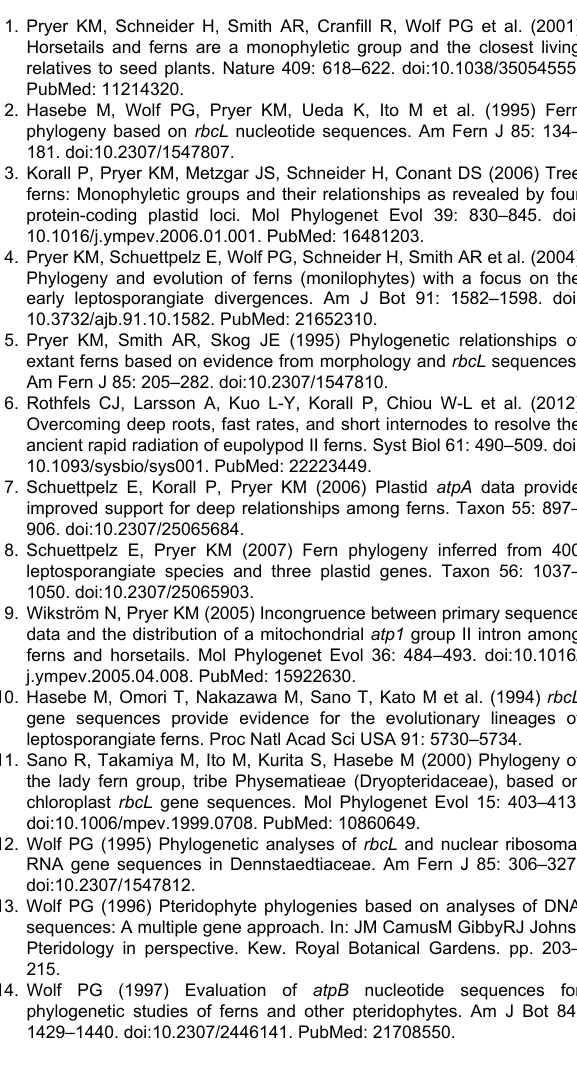
Figure S9. transducin all-in maximum likelihood transcriptome